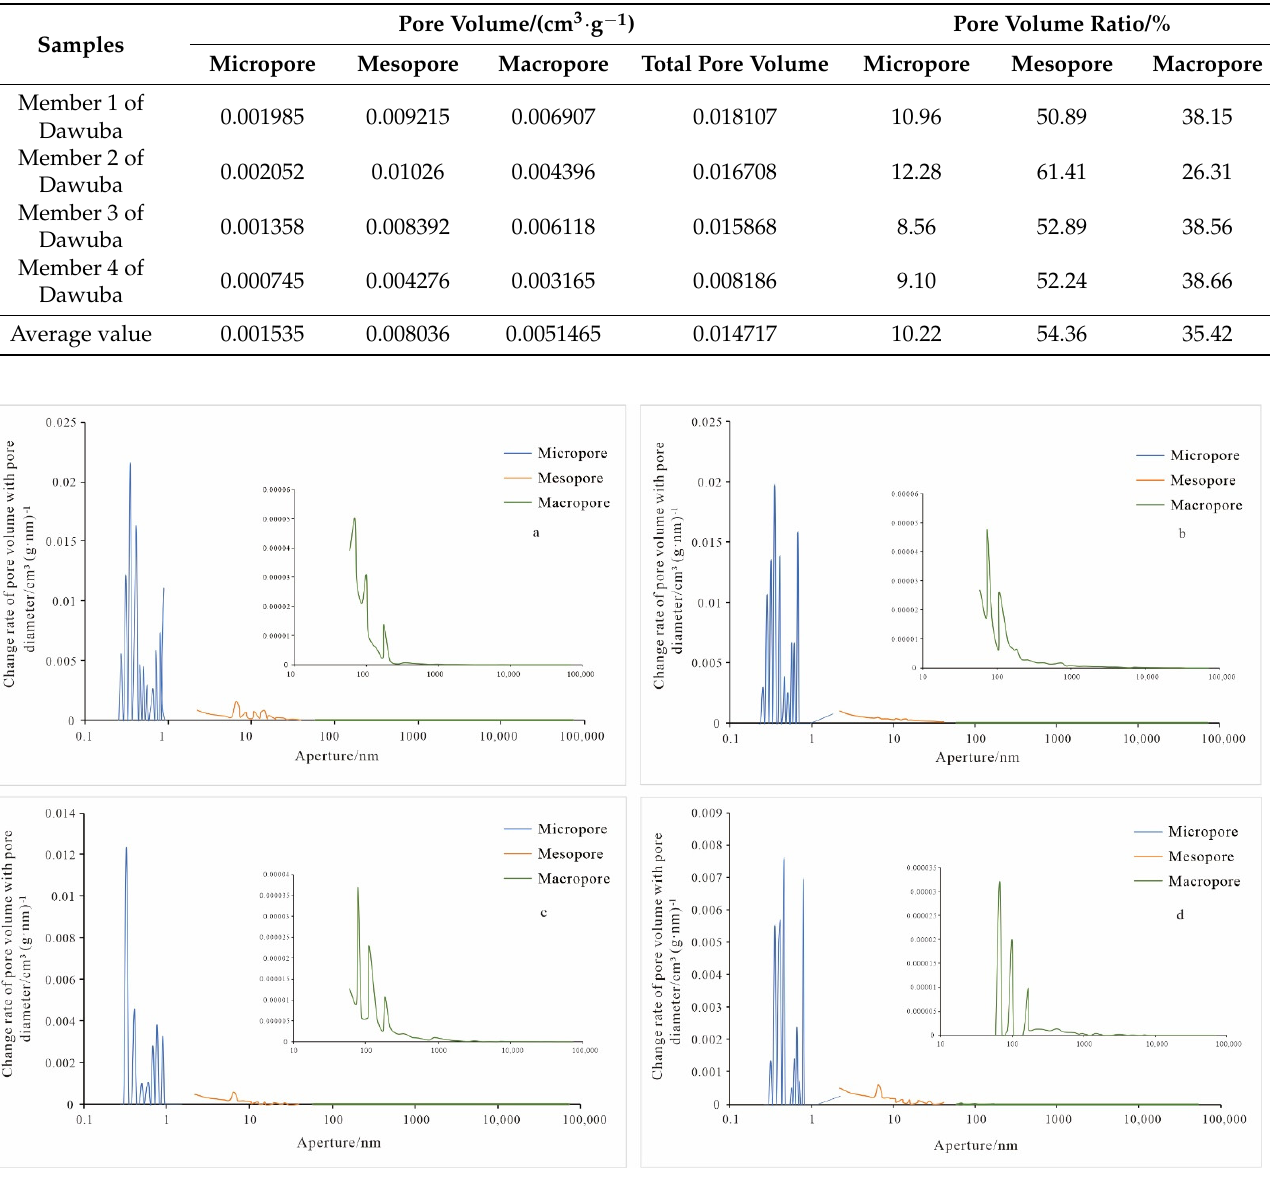
Figure 7. Variation rate curve of total pore volume with pore diameter of Dawuba Formation shale in the Qianxi area. ( a ) Member 1 of the Dawuba Formation; ( b ) member 2 of the Dawuba Formation; ( c ) member 3 of the Dawuba Formation; ( d ) member 4 of the Dawuba Formation. From the analysis of the specific surface area provided by the shale pores, the specific surface area of the shale pores in the Dawuba Formation in the study area is mainly provided by micropores and mesopores. Pores contribute 93% of the specific surface area of the shale in the Dawuba Formation, and pores less than 0.6 nm in each member are the main contributors to the specific surface area. With the increase of pore diameter, the specific surface area shows a downward trend; the specific surface area provided by the mesopores is generally less than 0.5 m 2 /g, and the specific surface area provided by the macropores is one order of magnitude smaller than that of the mesopores (Figure 8, Table 3).